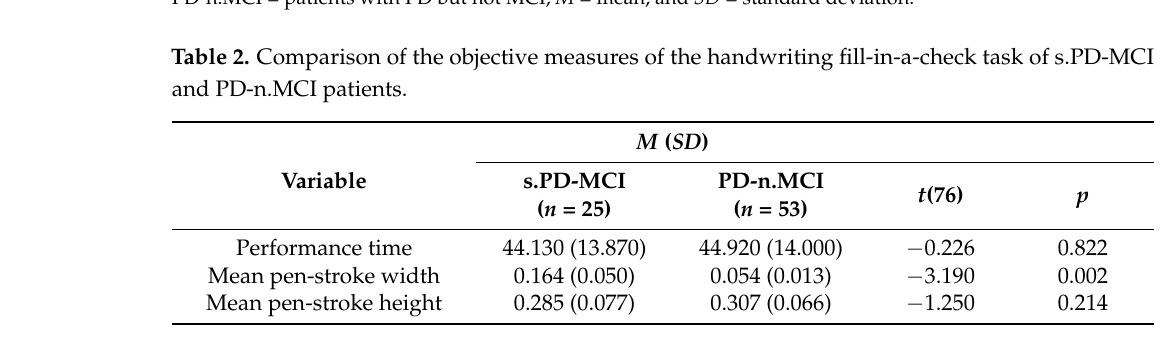
Table 1. Comparison of the item and mean final scores of the perceived general functional ability of